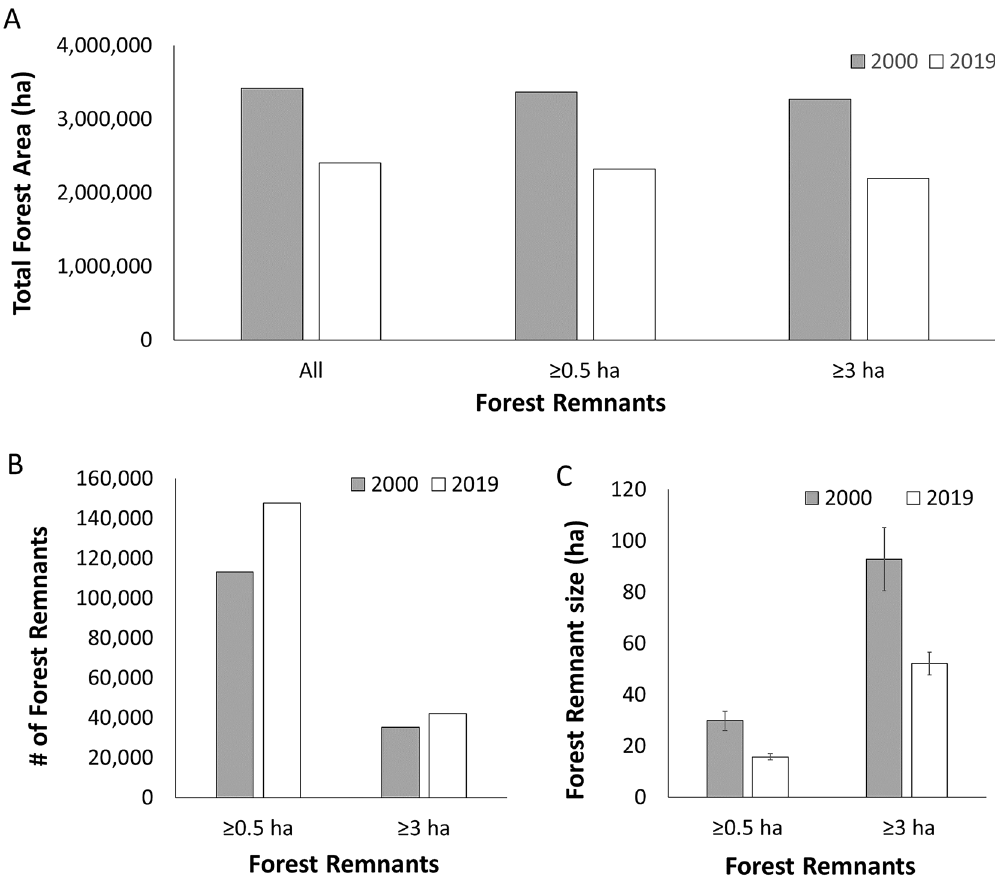
Figure 2. Interior Atlantic Forest in Paraguay ( A ) decreased by approximately 30% from 2000 to 2009, with ( B ) an increase in the number of forest remnants and a decrease in mean size during this time period. ( C ) Mean remnant size decreased from 2000 to 2019 when considering all forest remnants ≥ 0.5 ha as well as when considering all forest remnants ≥ 3